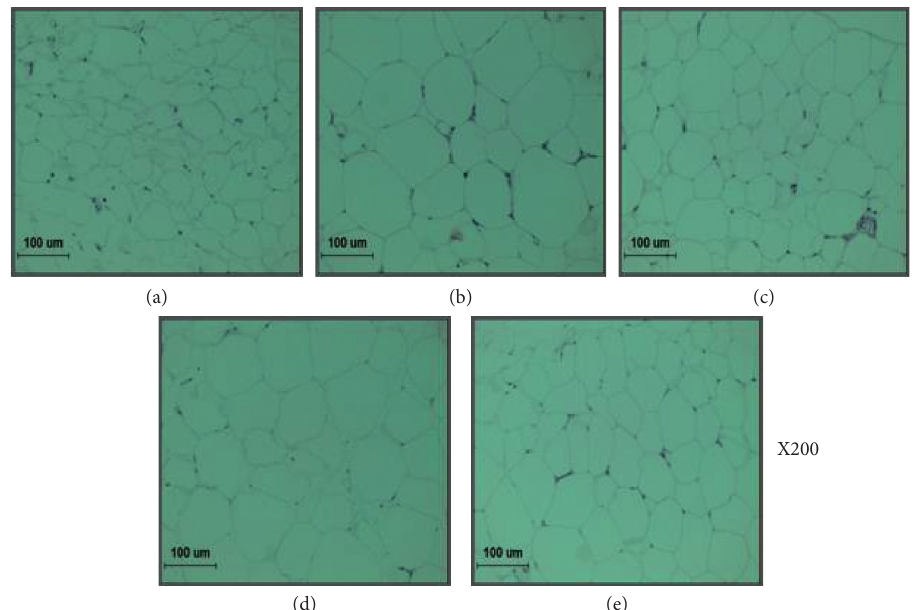
Figure 2: H/E staining of adipose tissue: (a) normal mice, (b) HFD control mice, (c) orlistat 60 mg/kg-treated and obese mice, (d) PCM 50mg/kg-treated and obese mice, and (e) PCM 100 mg/kg-treated and obese mice ( × 200).